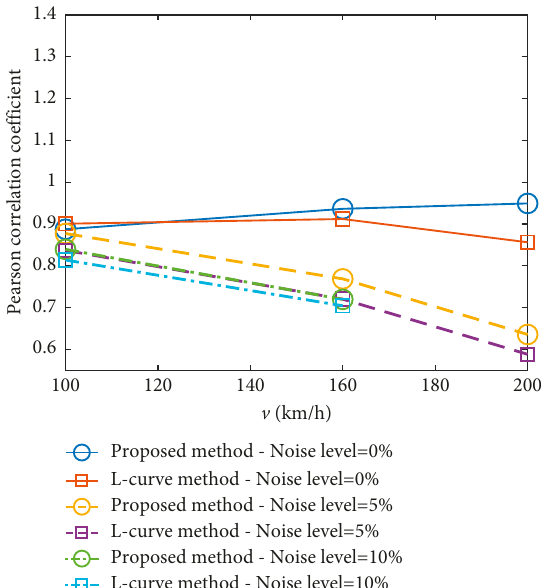
Figure 37: The relationships between the correlation coefficient with vehicle speed and noise level.